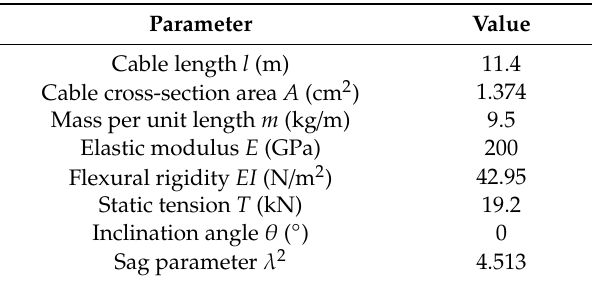
Table 1. Properties of the model